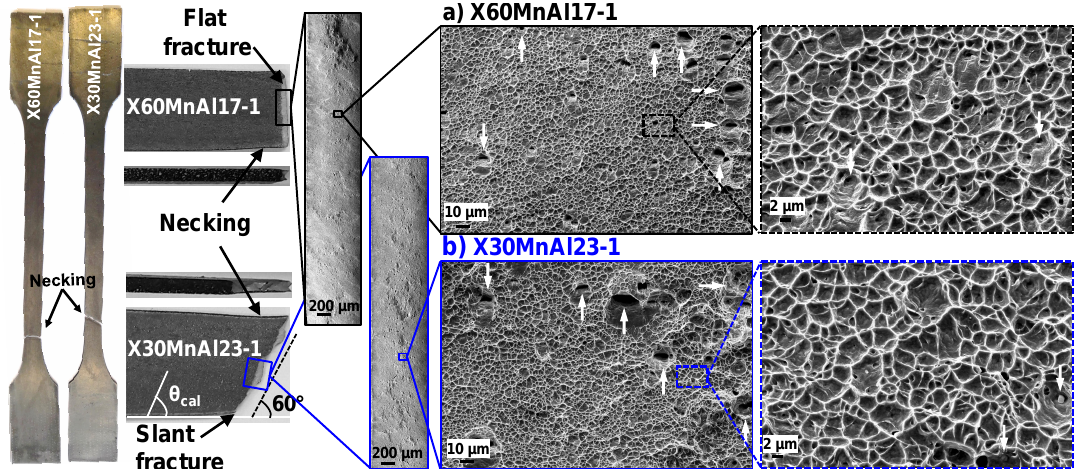
Figure 12. Fracture behavior of tensile specimens. Diffuse necking and fracture surface appearance ( left ) and SEM images of the fracture surfaces at different magnifications ( right ). Average dimple size of both X60MnAl17-1 and X30MnAl23-1 is approximately ≤ 2.5 µm. White arrows indicate large elliptical voids at MnS and AlN